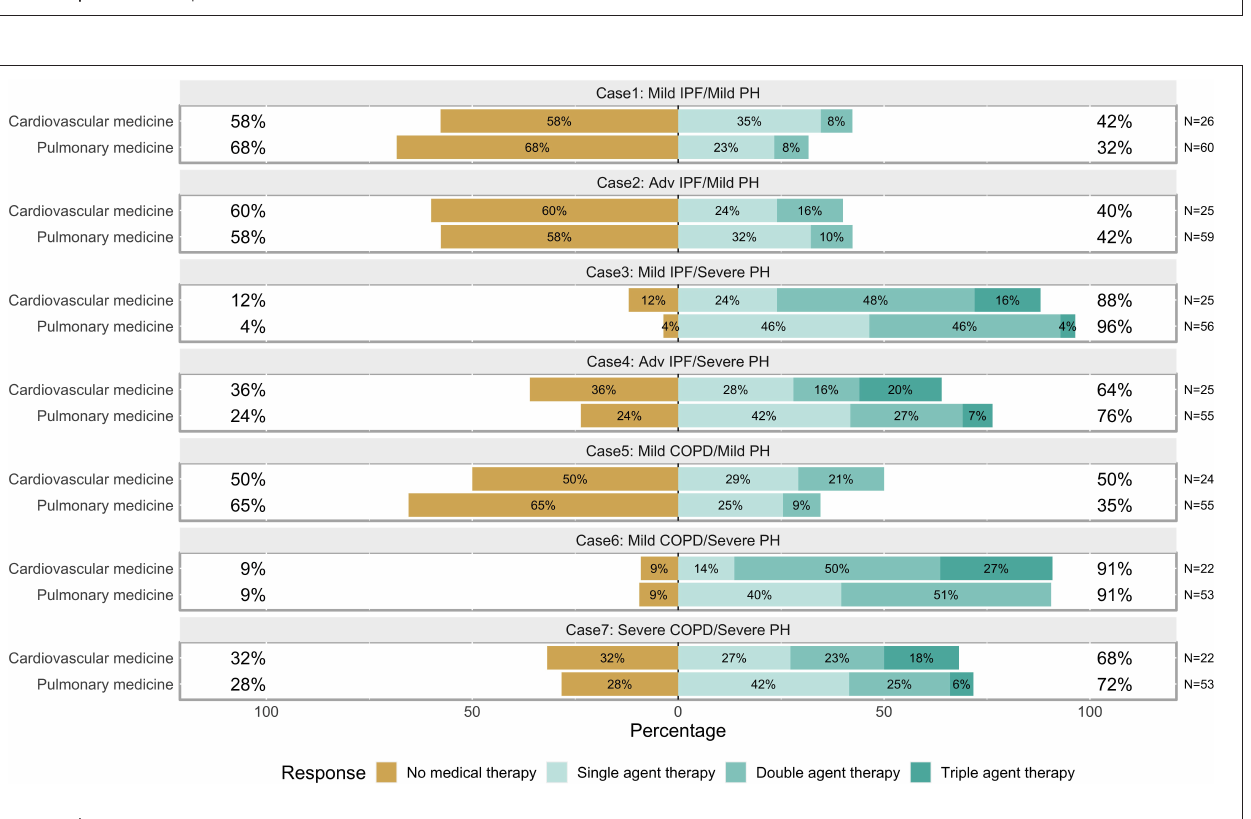
FIGURE 3 | Plot of the responses to each of the seven cases.